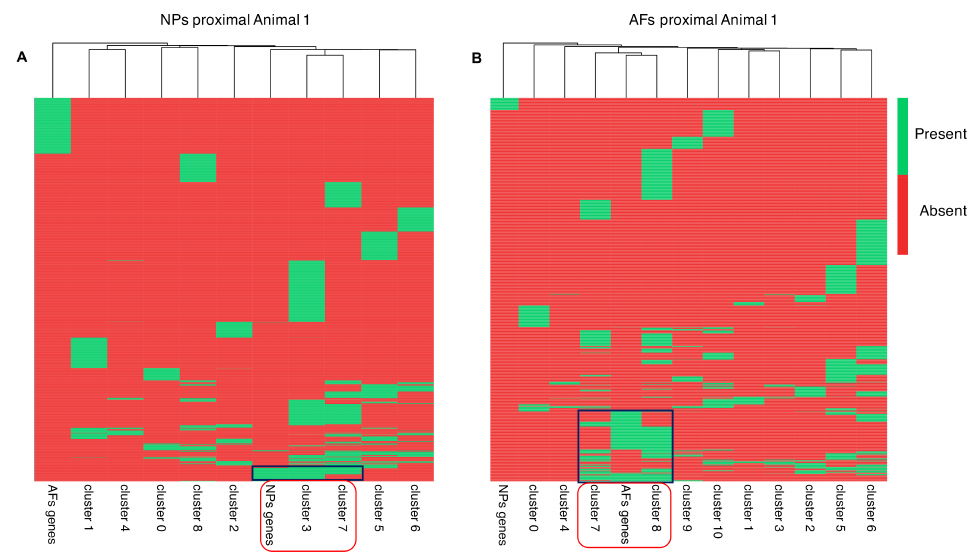
Figure 8. Heat map scRNAseq cluster. Heat map of exclusive AF and NP genes in the scRNAseq data, expressed in the NPs proximal and and AFs proximal of Animal 1. ( A ) The first heat map depicts the cell clusters that express NP genes. ( B ) The second heat map depicts cell clusters that express AF genes. The dendrogram at the top is a function of the amount of commonly expressed genes.